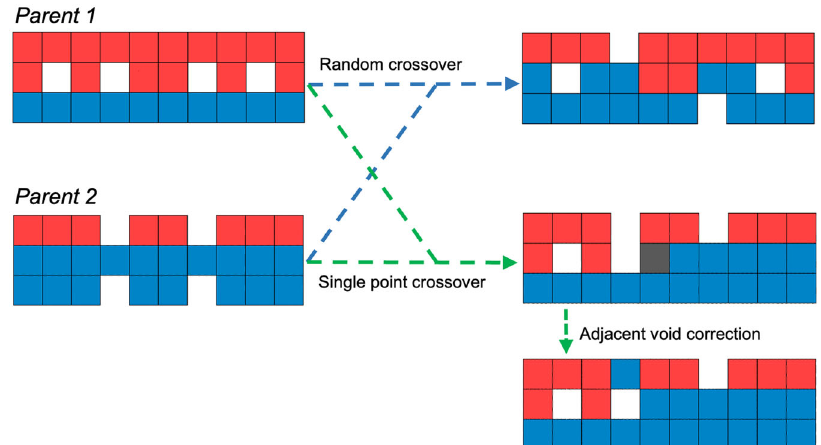
Fig. 3 Random crossover. Every voxel has a 50 – 50 chance of inheriting the properties from either parent, and single point crossover where two children are produced from two parents with genome splicing at one point (represented here by the grey voxel).